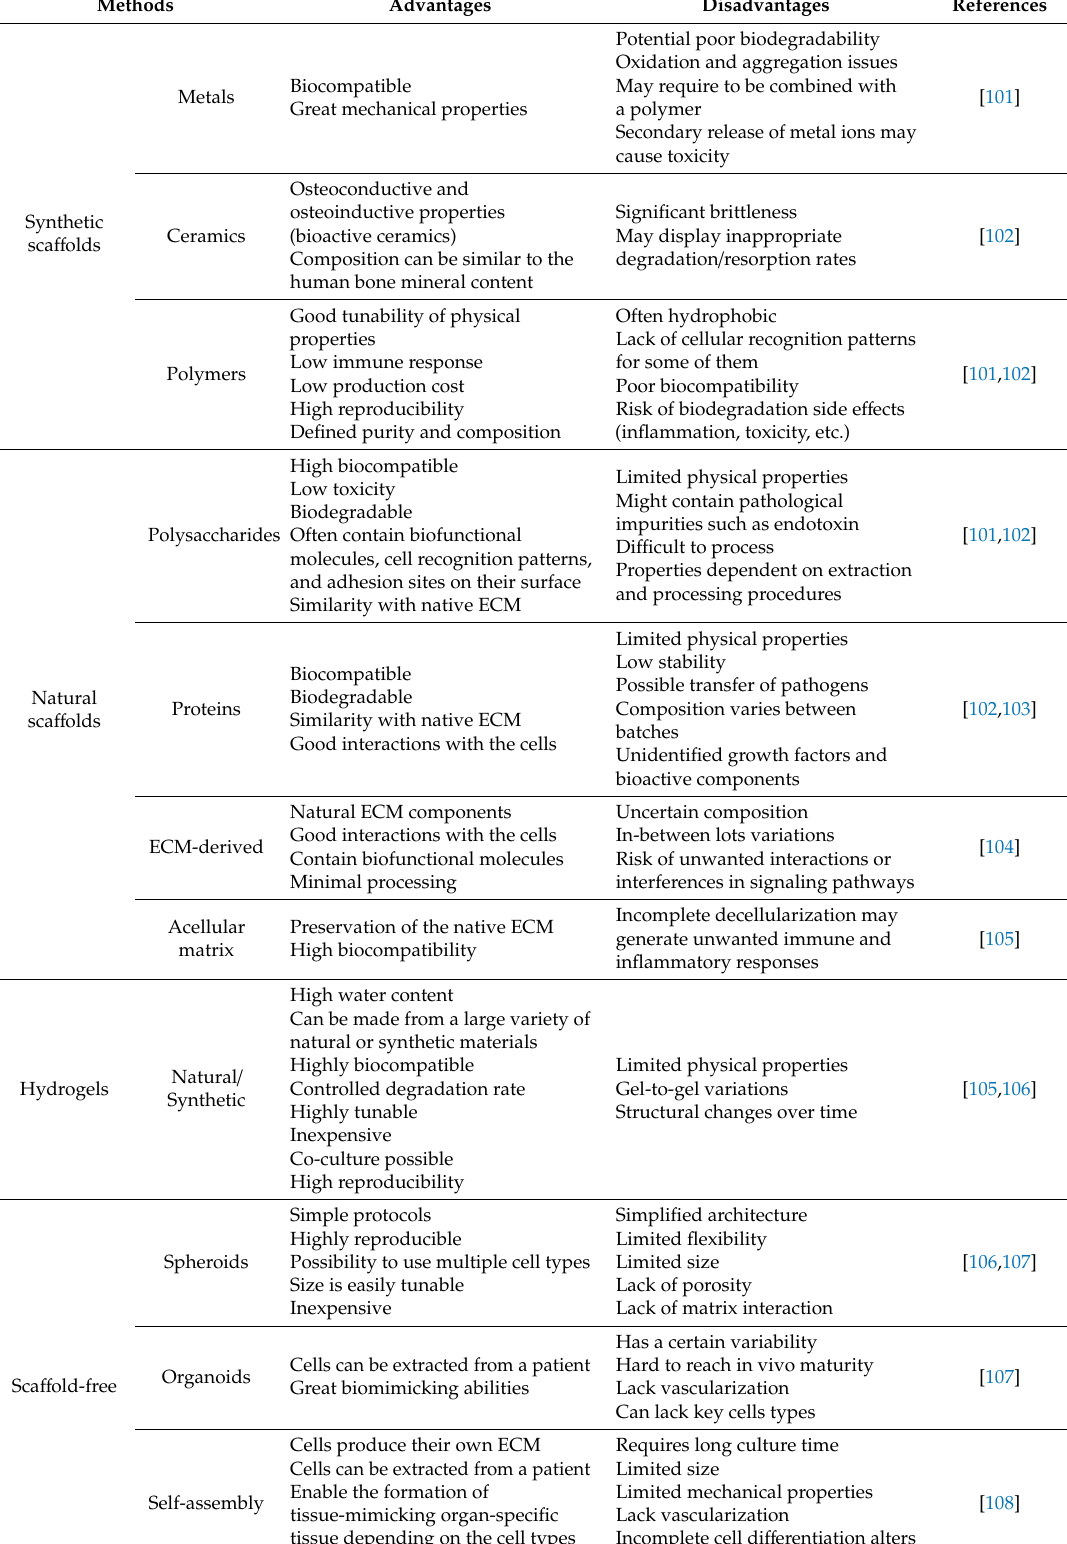
Table 2. Advantages and disadvantages of 3D cell culture